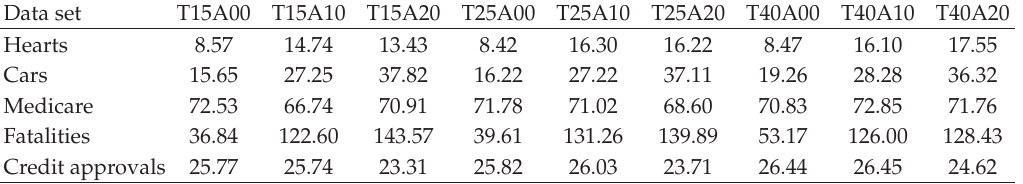
Table 2: Missing values in all the variables: mean relative error across the weightings. Data set